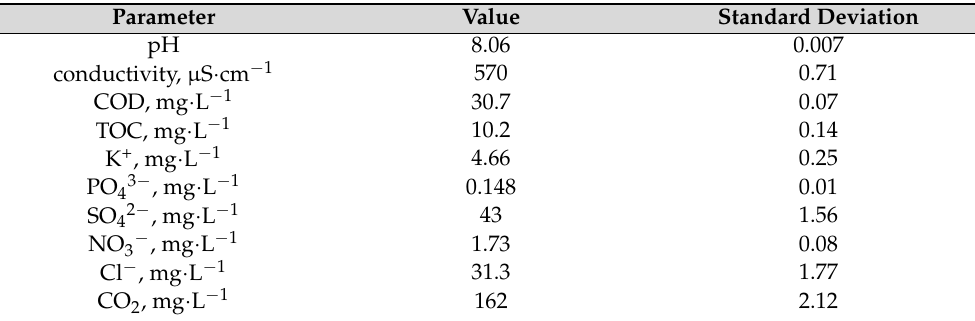
Table 3. Characteristic parameters of natural river water (RW)